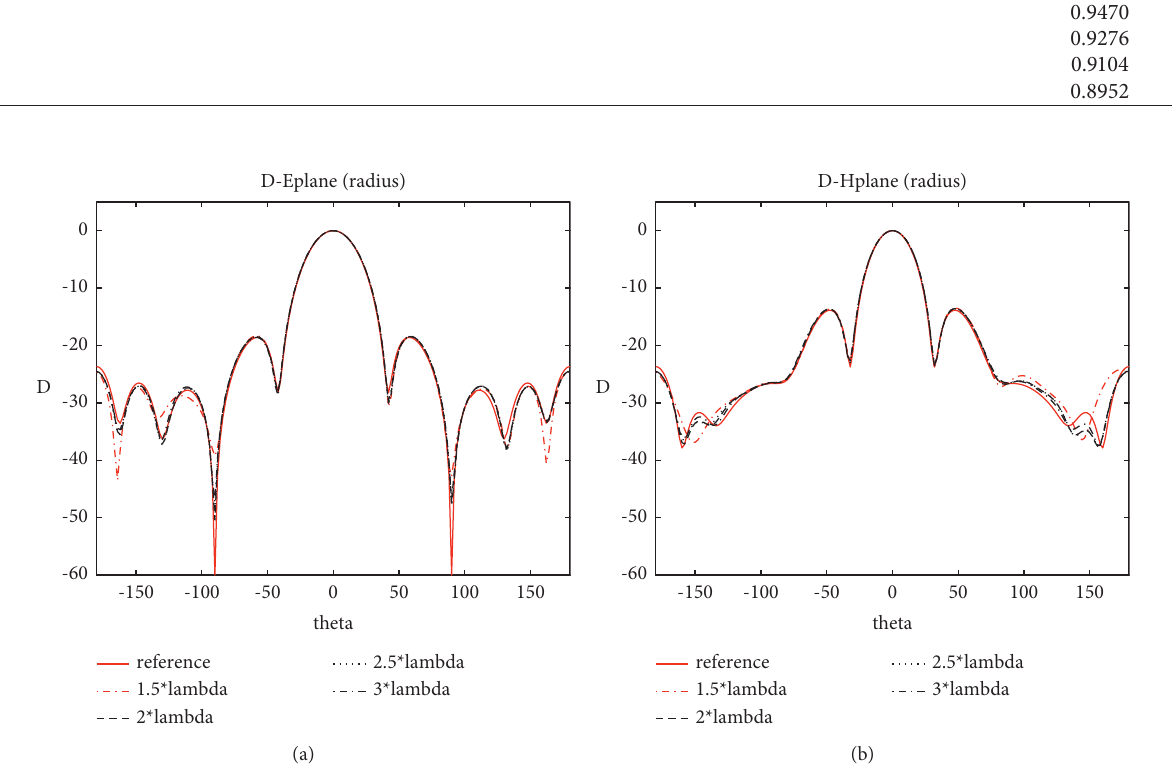
Figure 8: The radiation pattern corresponds to radius difference. (a) E-plane. (b)